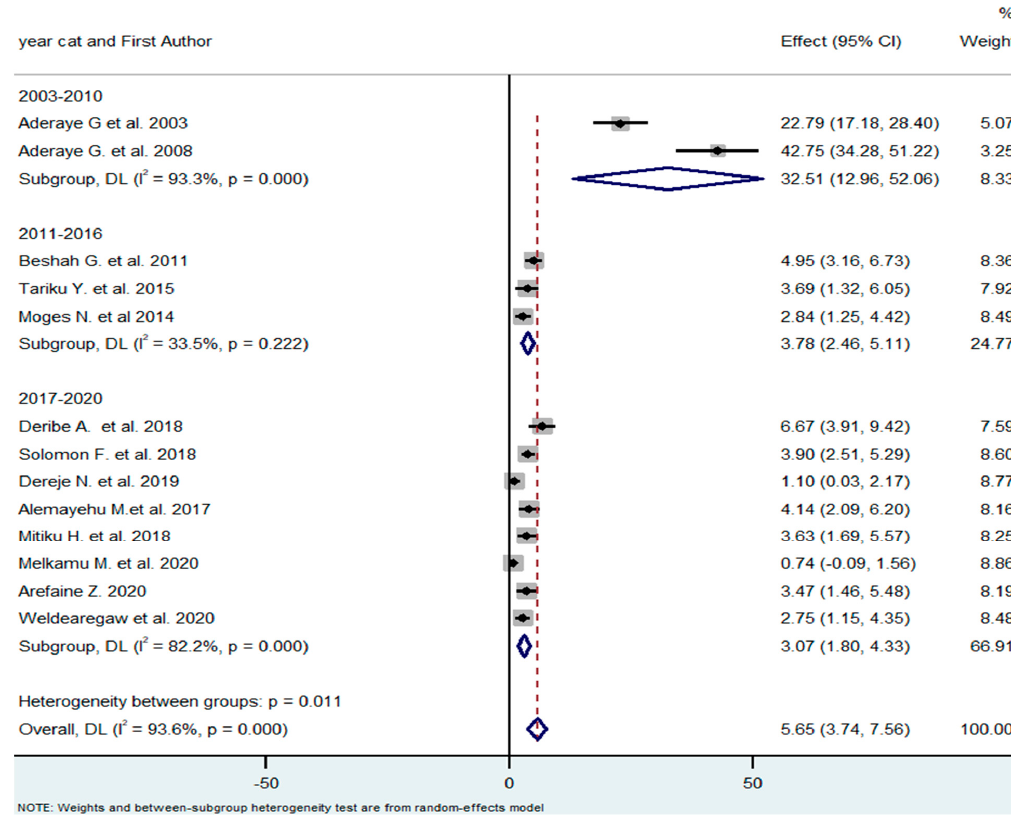
Figure 4. Subgroup analysis by year of publication [18,21,26–36].